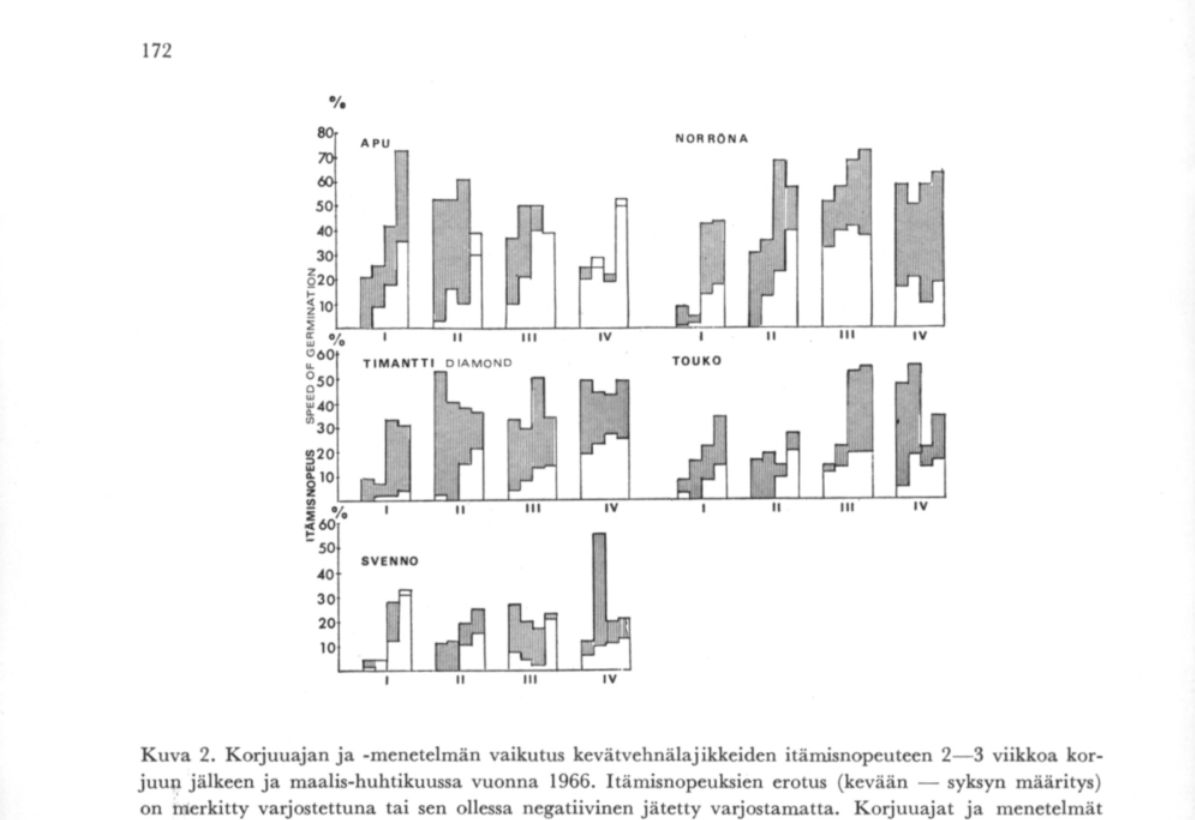
Fig. 2. Effects of harvesting time and harvesting method upon the speed of germination of spring wheat cultivars in 1966. Speed of germination is determined 2 —3 weeks after harvesting and in March-April. The differences in the two deter- minations (spring determination autumn determination) is shaded in or left white when negative. Harvesting times and methods are same as in Fig.